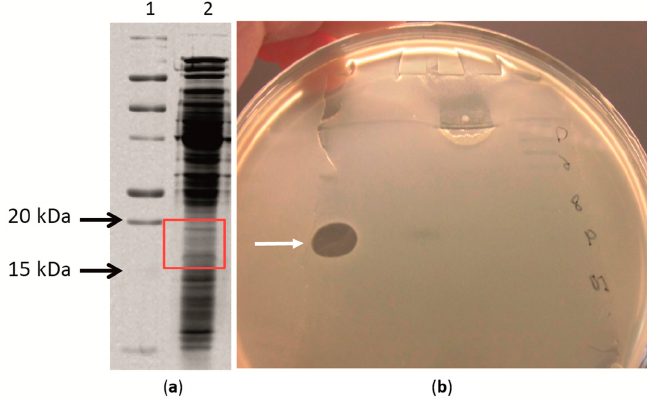
Figure 3. Analysis of the antibacterial activity of the desalted protein fraction isolated from the culture supernatant produced by Geobacillus sp. ZGt-1 at 60 °C. The test organism was G. stearothermophilus strain 10. After SDS-PAGE separation of the protein in duplicates, the gel was divided into two, one part stained with Coomassie Brilliant Blue R 250 ( a ) and the other used for antibacterial assay ( b ). ( a ) Image of the SDS-PAGE separated protein fraction. Lane 1 : Precision Plus Protein All Blue standards; Lane 2 : Desalted protein fraction; ( b ) Antibacterial activity of the desalted protein extract after separating it on SDS-PAGE separated protein; the gel strip was placed in a Petri dish and covered with soft agar layer seeded with strain 10 and incubated at 60 °C. The white arrow is pointing to the inhibition zone ascribed to the antibacterial activity of the protein fraction. The inhibition zone corresponded to 15–20 kDa.